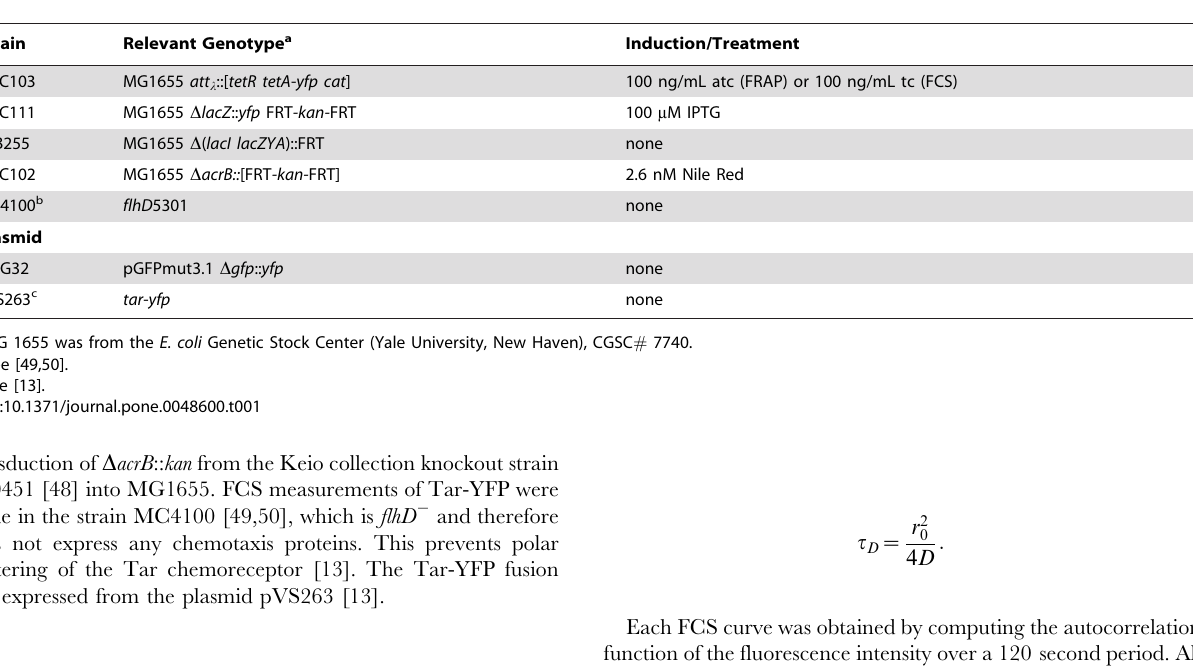
Table 1. The plasmids and strains used in this